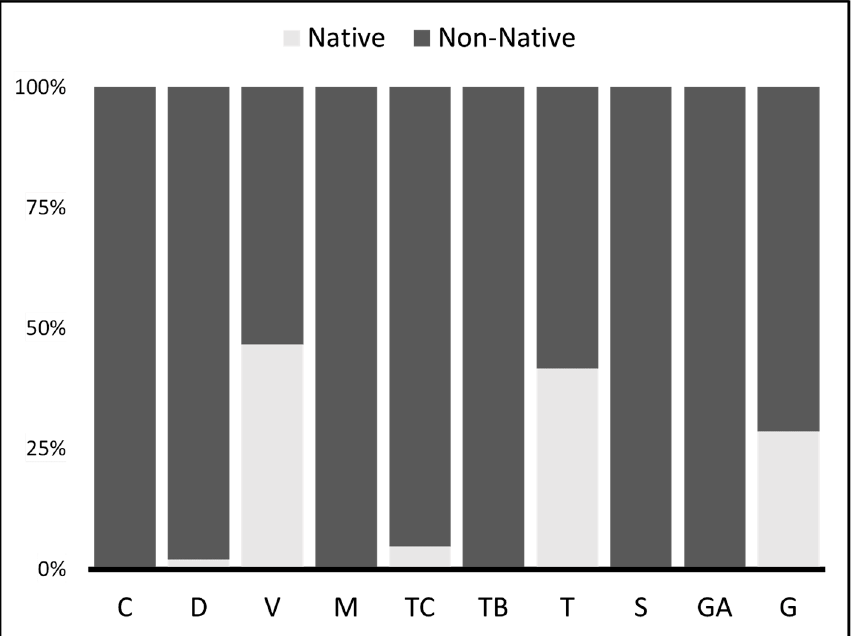
Figure 3. Consumption on Native vs. Non-Native fish preys by pikeperch Sander lucioperca popula- tions in Portuguese basins. Light grey (Native), dark grey (Non-Native).